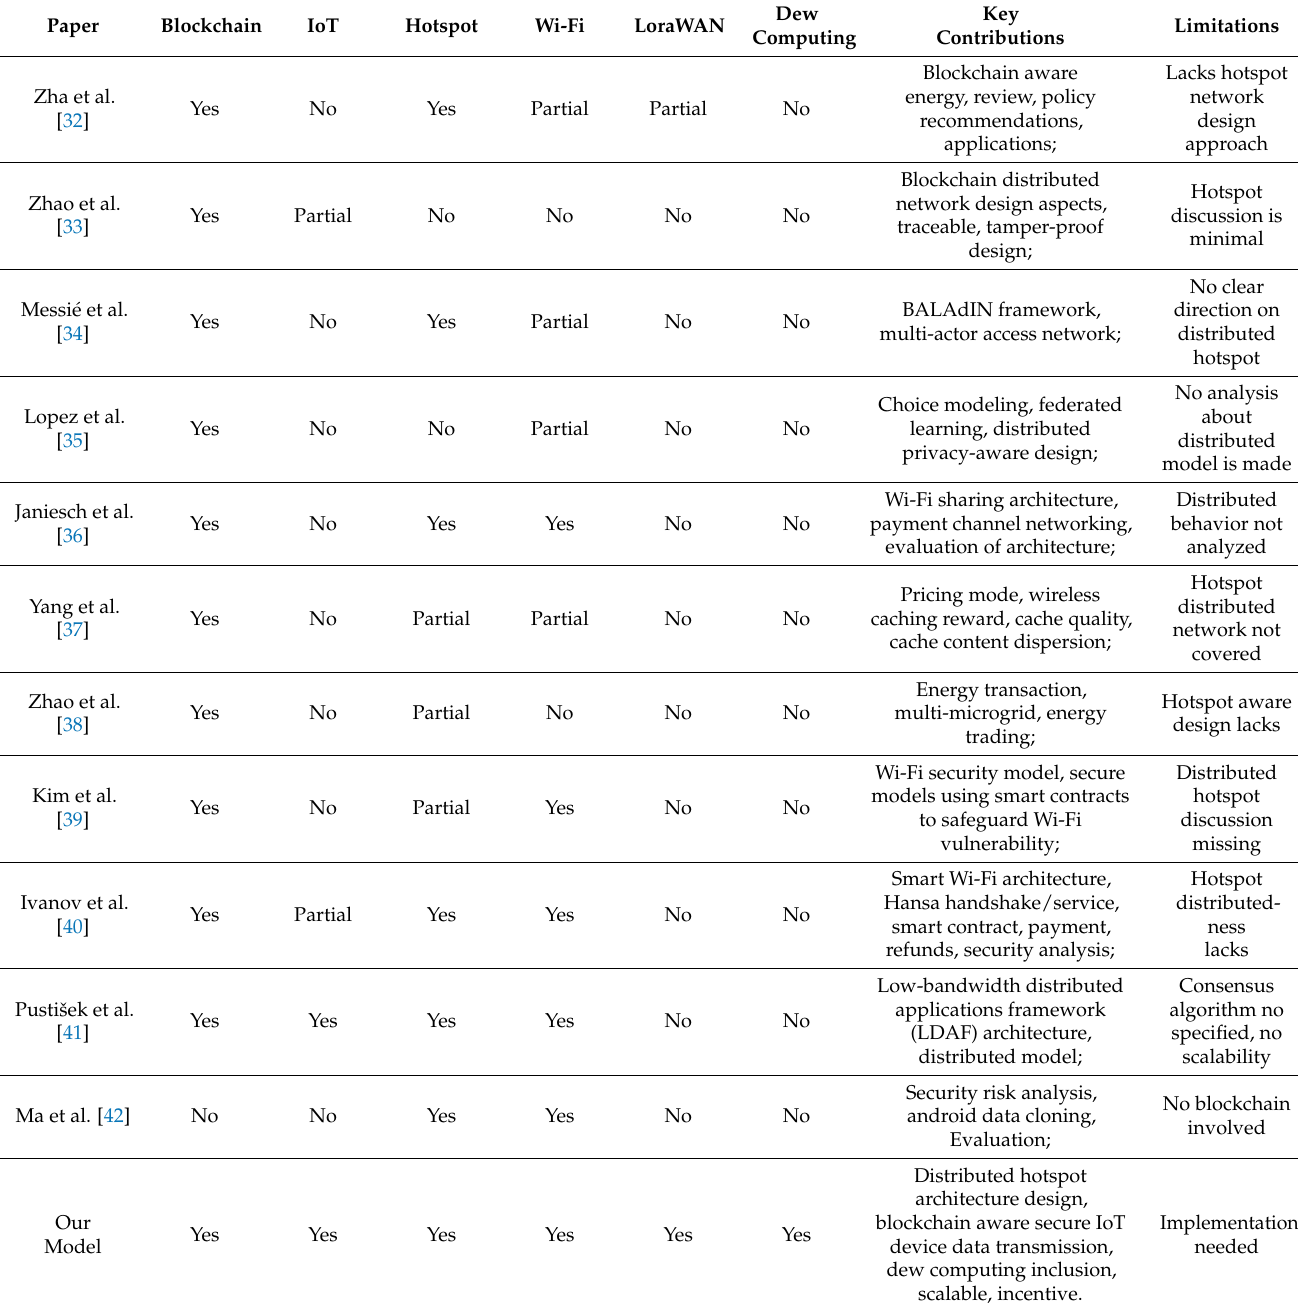
Table 1. Comparative analysis of related